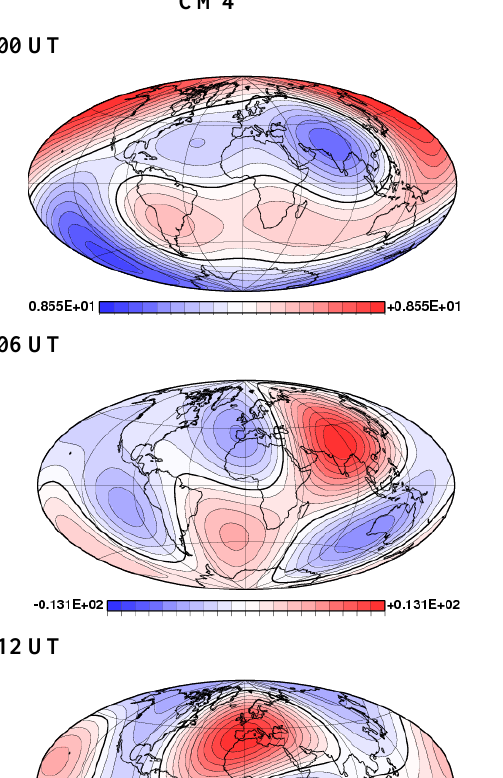
As the spherical harmonic degree truncation is increased to 3 ( n = 3) (Fig. 6), more details of the diurnal field are revealed in terms of the areas of strong and weak inten- sities. Here we can observe some similarities between the CM4 and data at all hours shown. As we increase the spher- ical harmonic to even higher degree truncation, from 3 to 5 ( n = 3–5), more complex details of the diurnal field are revealed (Fig. 7), and as we move to even higher spher- ical harmonic degree truncation, n = 7 (Fig. 8), we can see the diurnal field’s increasingly complex structure